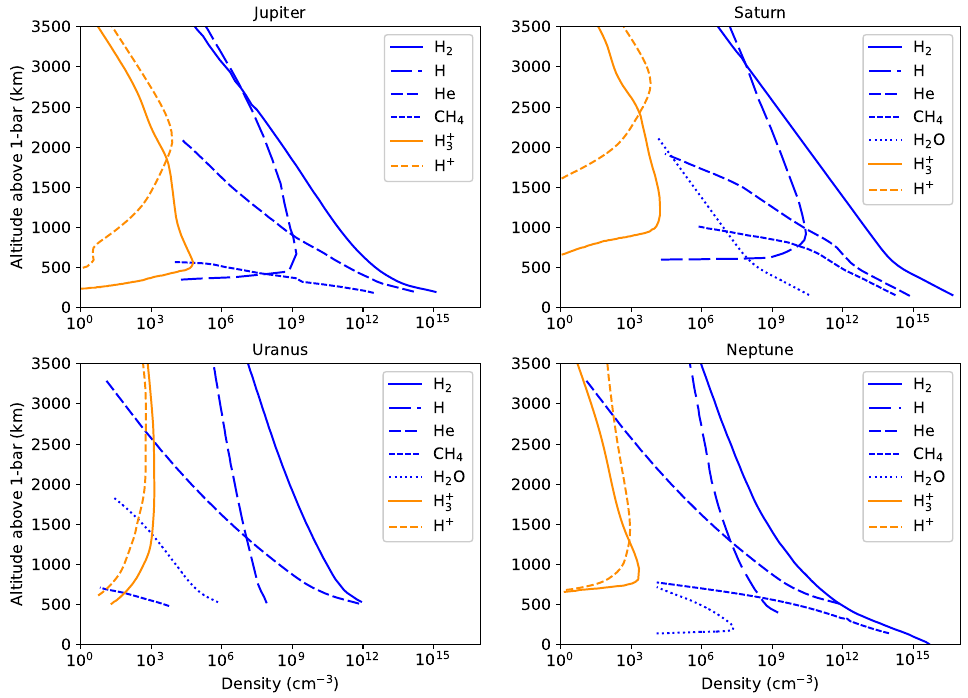
Figure 2. Number densities of major neutral and ion species are shown as a function of altitude above the 1-bar pressure surfaces of the four giant planets. The plots show modeled densities for Jupiter and Saturn [21], Uranus [17] and Neptune [18]. The solar zenith angle (where 90° corresponds to the Sun being directly overhead) varies in these models: 75° for Jupiter and Saturn, 15° for Uranus and 45° for Neptune, so care must be taken when comparing ion densities between the planets. In addition, Jupiter and Saturn ion densities are enhanced by charged particle precipitation associate with auroral